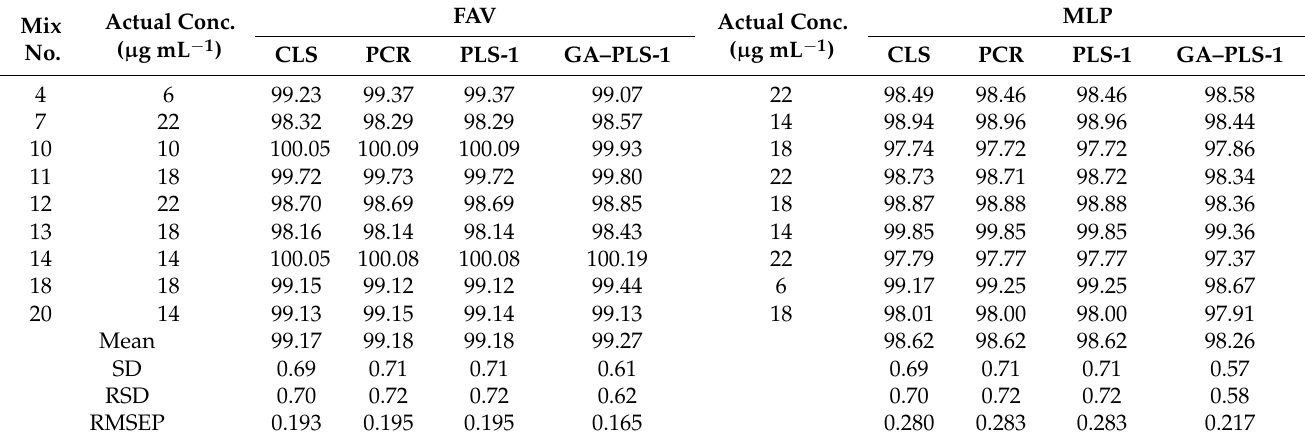
Table 3. Validation set results for the four developed chemometric